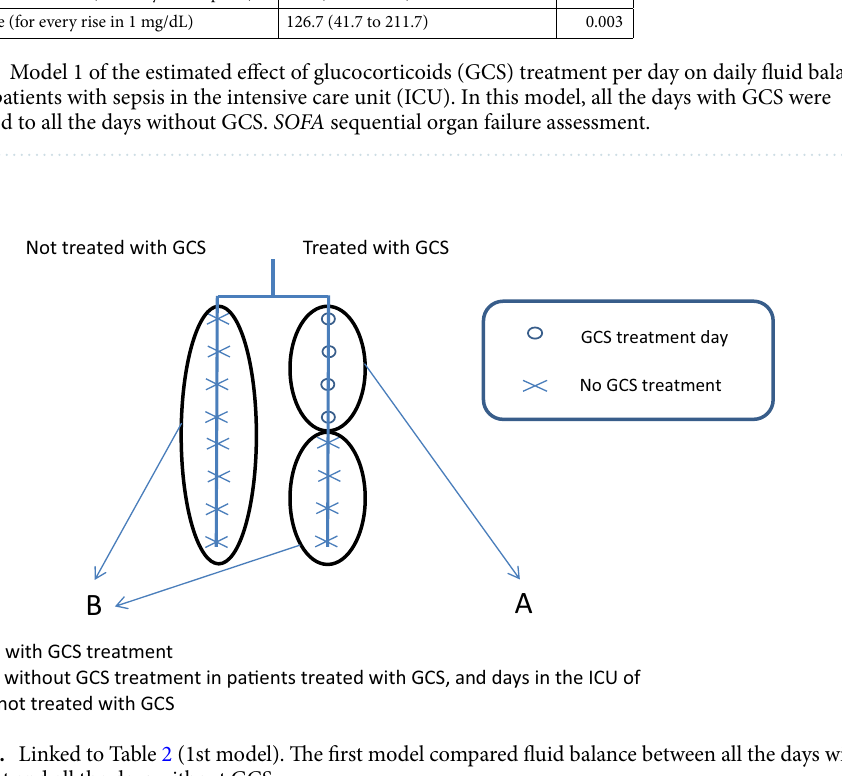
Figure 2. Linked to Table 2 (1st model). The first model compared fluid balance between all the days with GCS treatment and all the days without